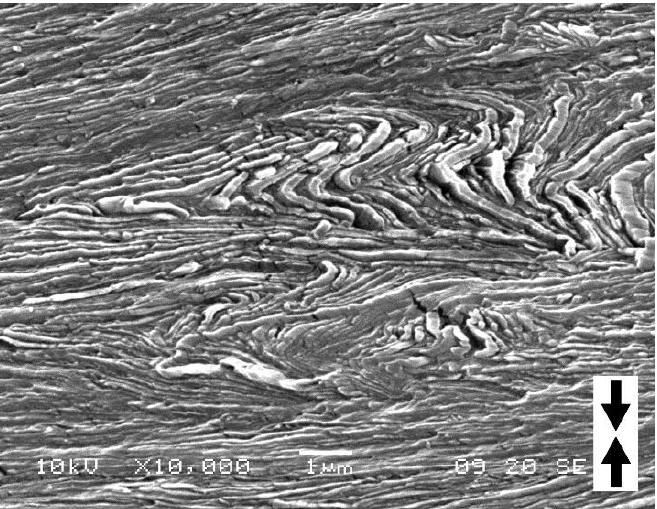
Figure 10. SEM micrograph of the H3-CE sample deformed by uniaxial compression to the true strain of e = 1.5 showing details of the mature kink. The direction of compression is vertical. Sample was etched prior to observation.